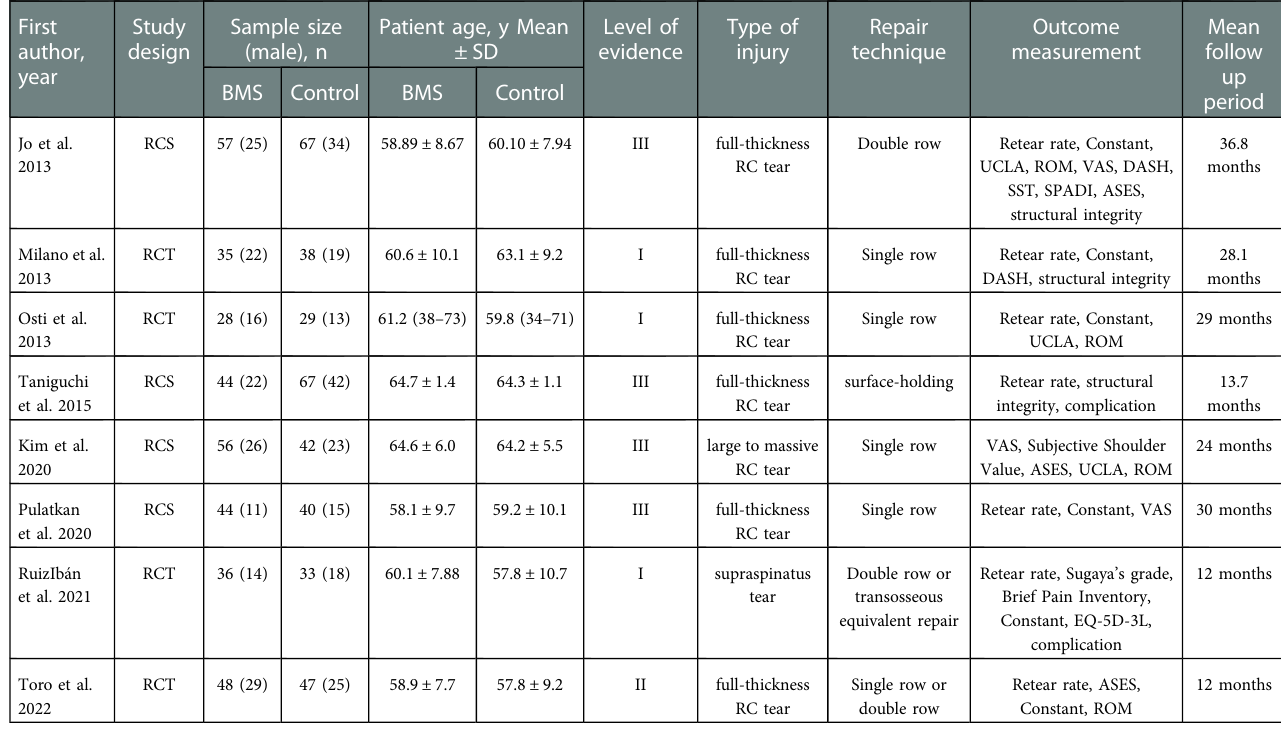
RCT, randomized control trial; RCS, retrospective cohort study; RC, rotator cuff; UCLA, University of California at Los Angeles; ROM, range of motion; VAS, Visual analog scale; DASH, Disabilities of the Arm, Shoulder and Hand; SST, Simple Shoulder Test; SPADI, Shoulder Pain and Disability Index; ASES, American Shoulder and Elbow Surgeons; EQ-5D-3L, EuroQol Five Dimensions